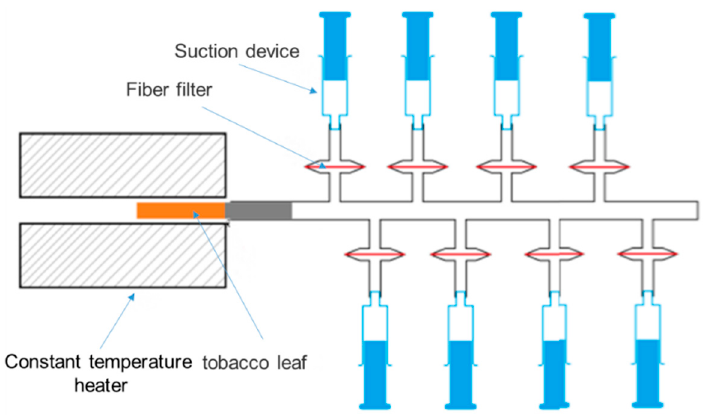
Figure 1. The self-made fragrance release analysis system.